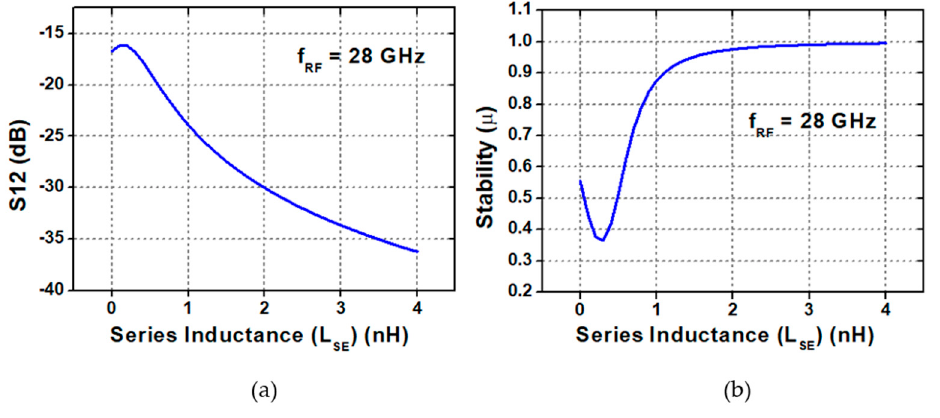
Figure 4. Simulation results of the common-source single stage adopting series inductor: ( a ) a S 12 and ( b ) a stability µ criterion.